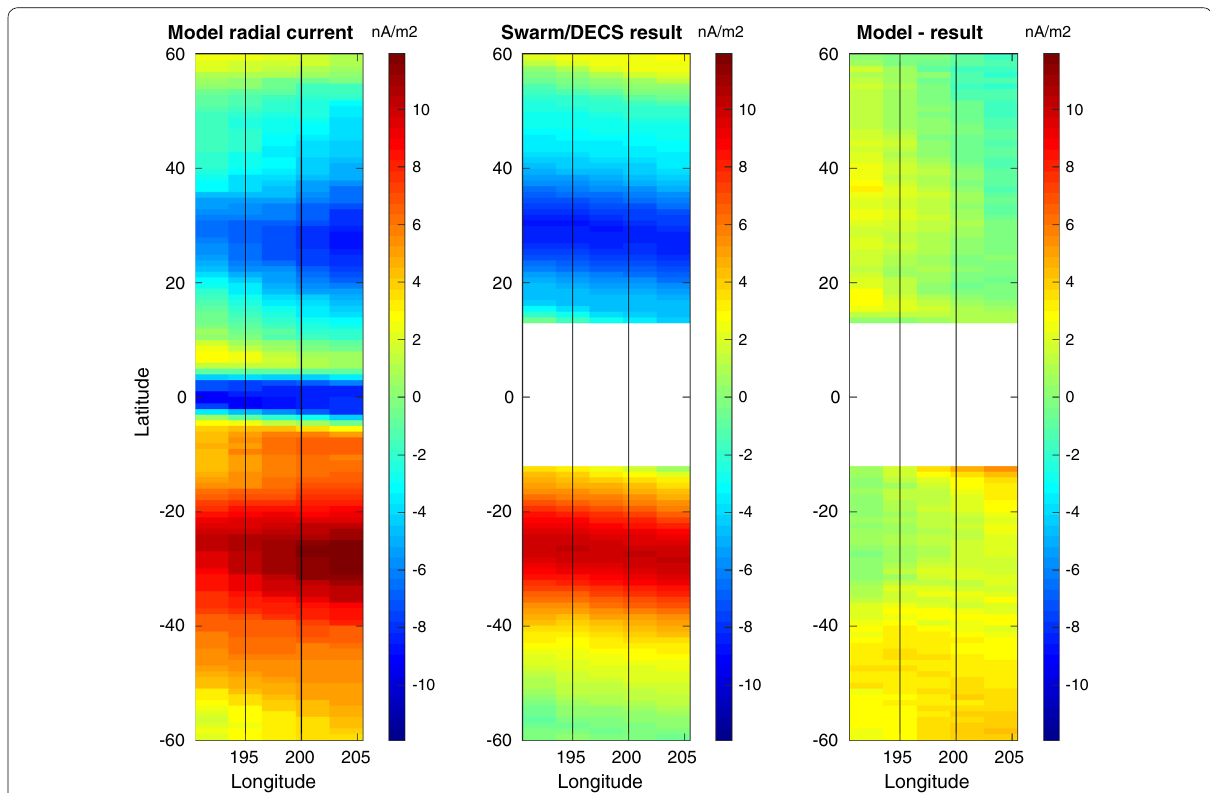
Fig. 5 Test T8. Map of the radial current. From left to right: The TIE-GCM model current, result from the Swarm/DESC analysis, and difference between the two. Swarm-A/C orbits are shown as black lines. Compare with the latitude profiles shown in the top panel of Fig. 3